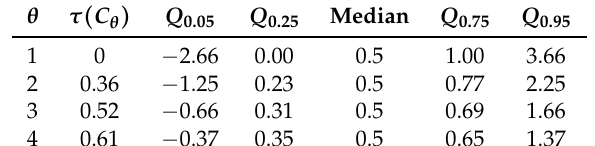
Table 12. Some percentiles of Y = X 1 / ( X 1 + X 2 ) , where ( X 1 , X 2 ) follows Joe Copulas.